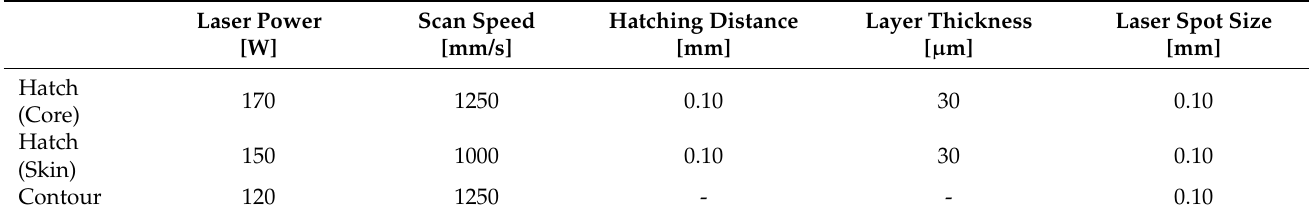
Table 2. EB-BPF process parameters [37].